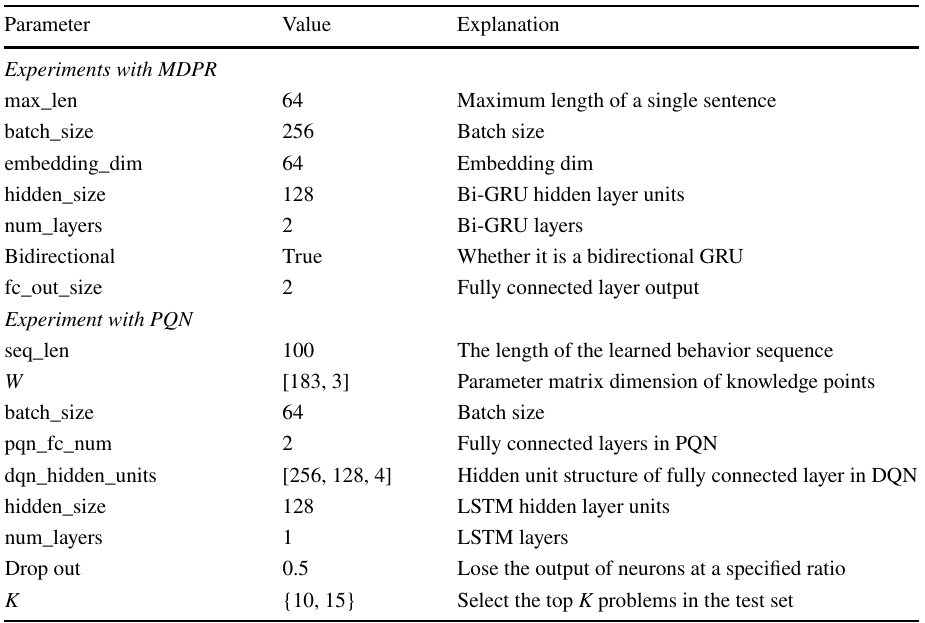
Table 4 Experimental parameter settings